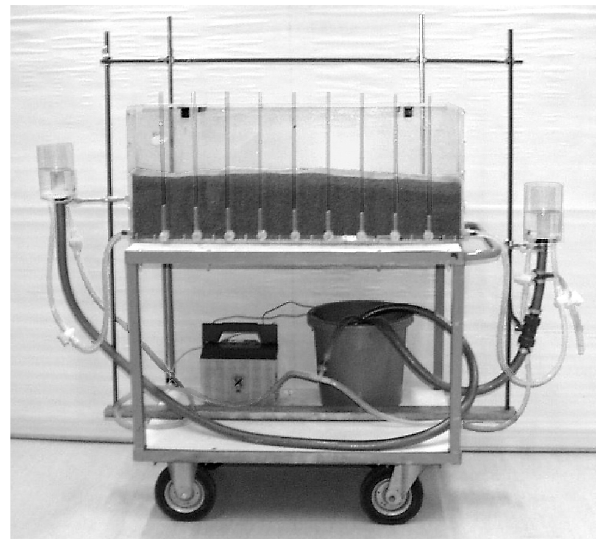
Fig. 1. Sand aquifer for classroom